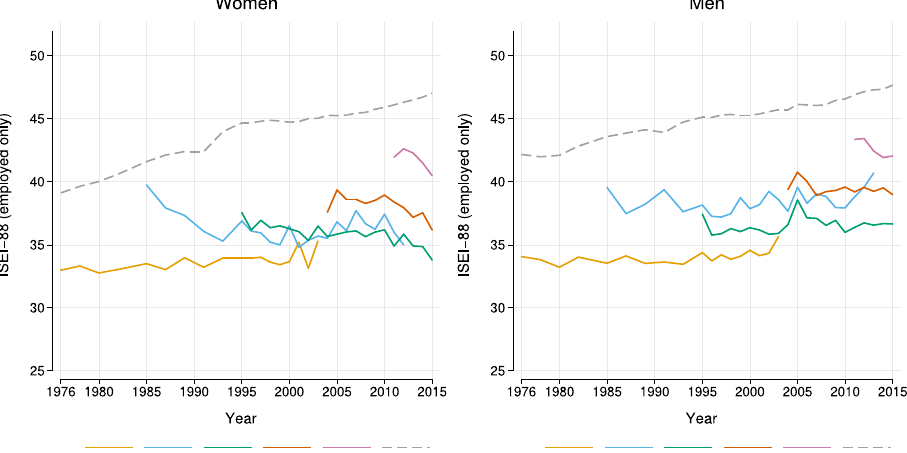
Figure 4 : Occupational status scores by period and arrival